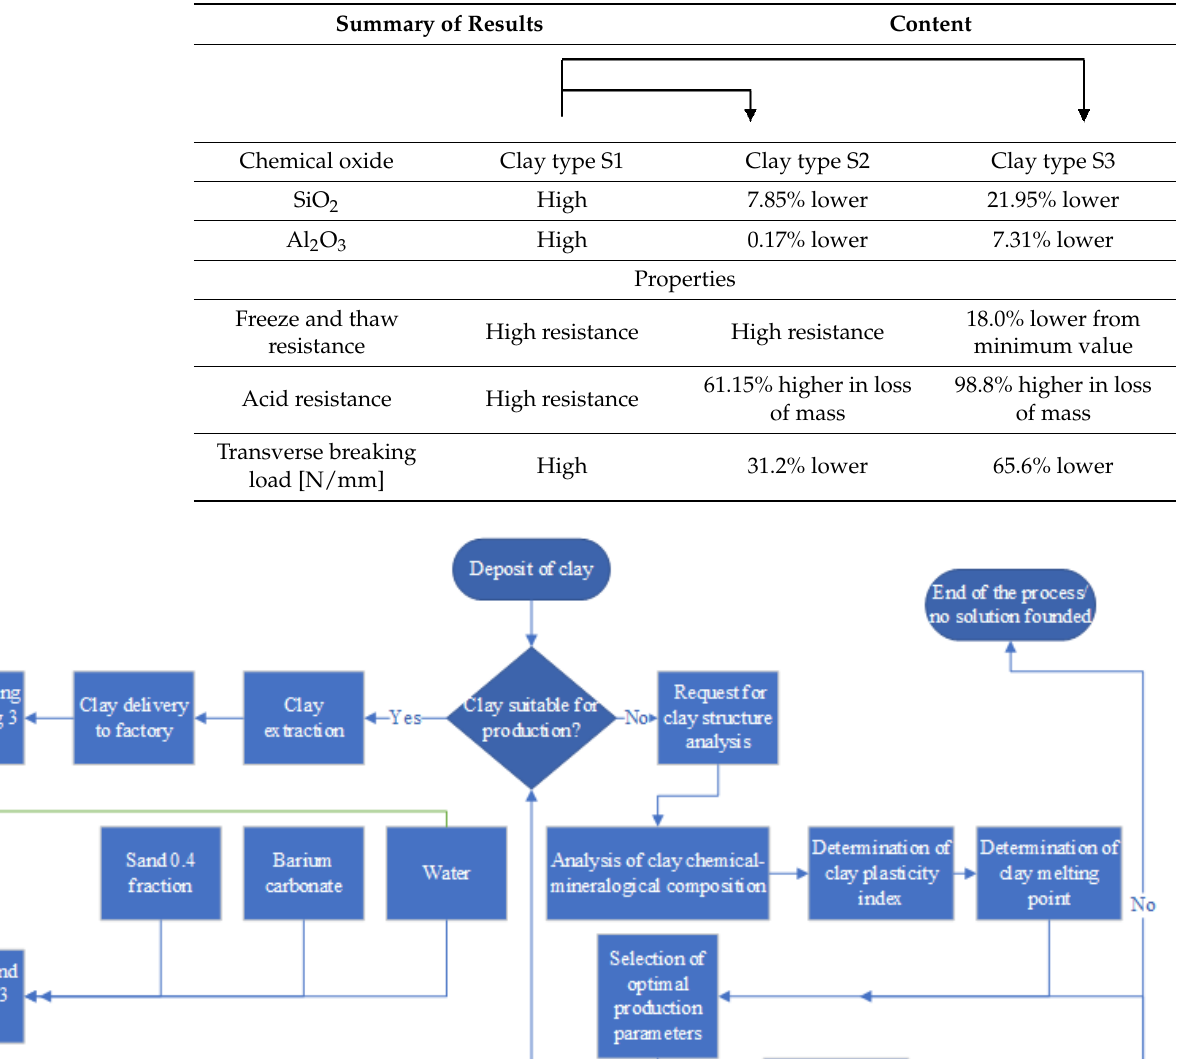
Table 7. Summary of experiment results.